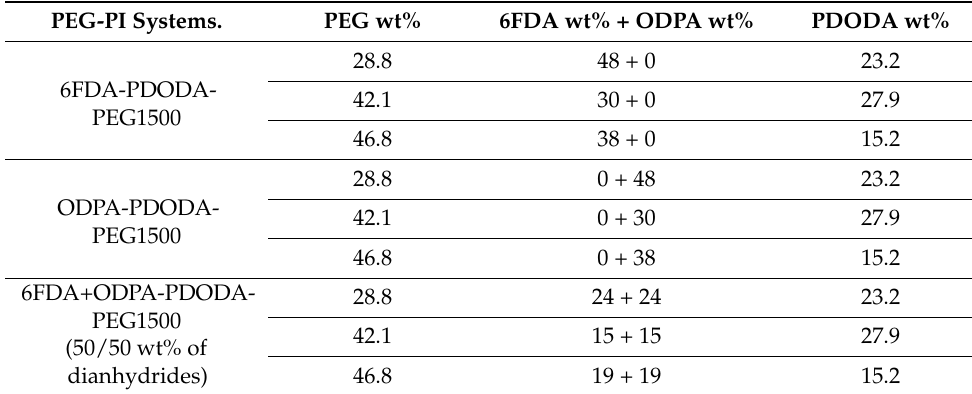
Table 1. SBC membrane systems with varying PEG1500 wt%.